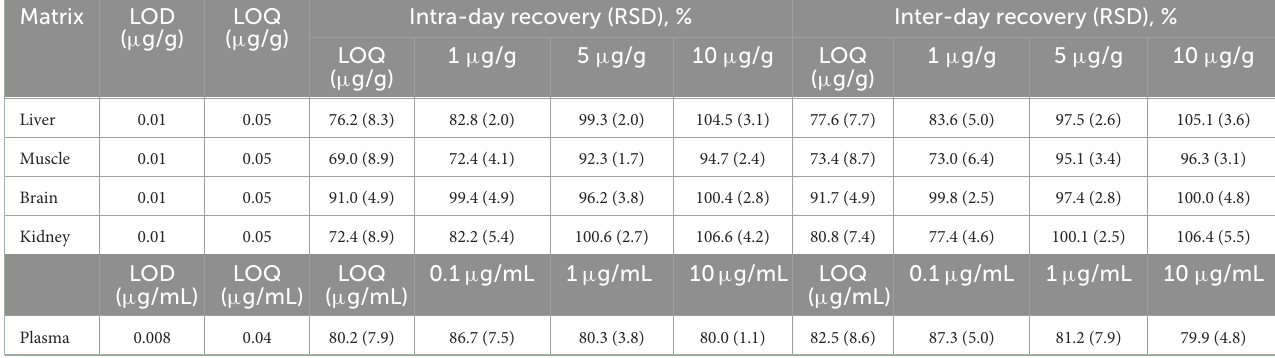
TABLE 1 Recovery and precision of eugenol in carp tissues and plasma ( n = 6) a .